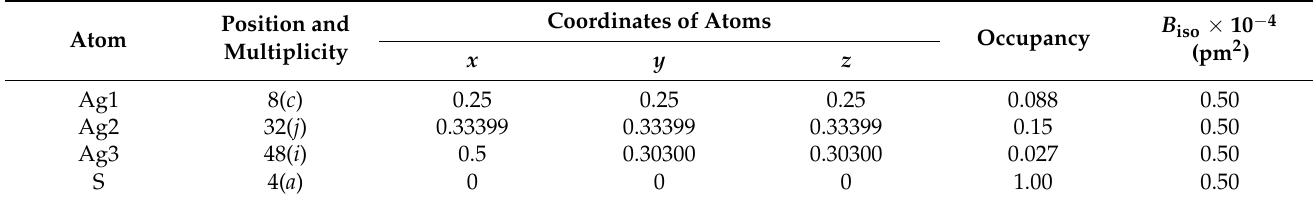
)) γ -Ag 2 S ( γ -Ag 1.7 S) silver sulfide h